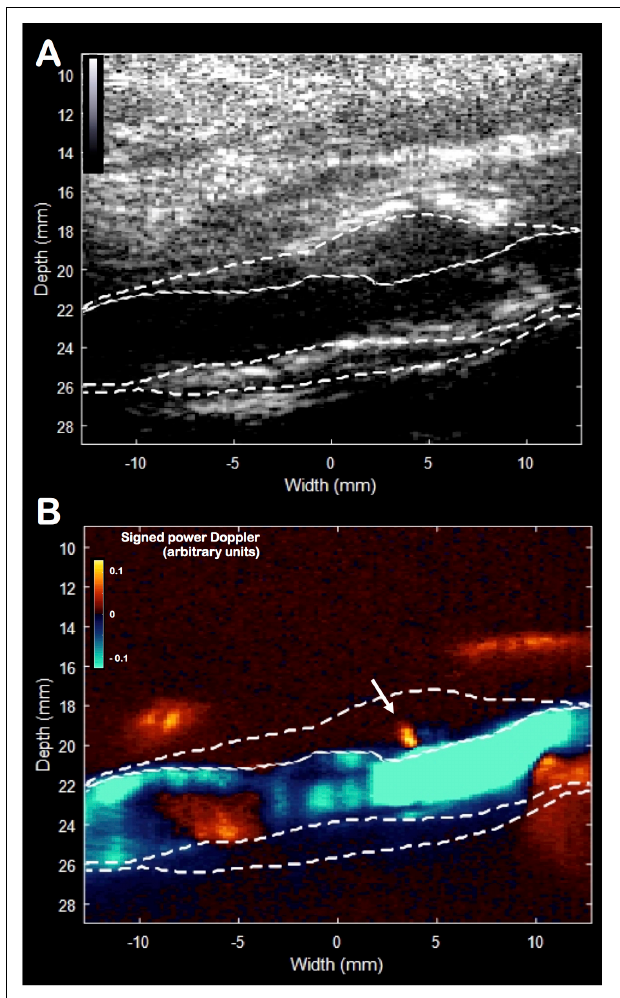
FIGURE 4 | Ultra-sensitive Doppler imaging. B-mode picture (A) and the signed power Doppler picture (B) . The plaque was manually delineated. The white arrow indicates the presence of an isolated centrifugal micro-flux originating from the lumen inside the plaque’s wall, which may correspond to a rupture zone of the fibrous